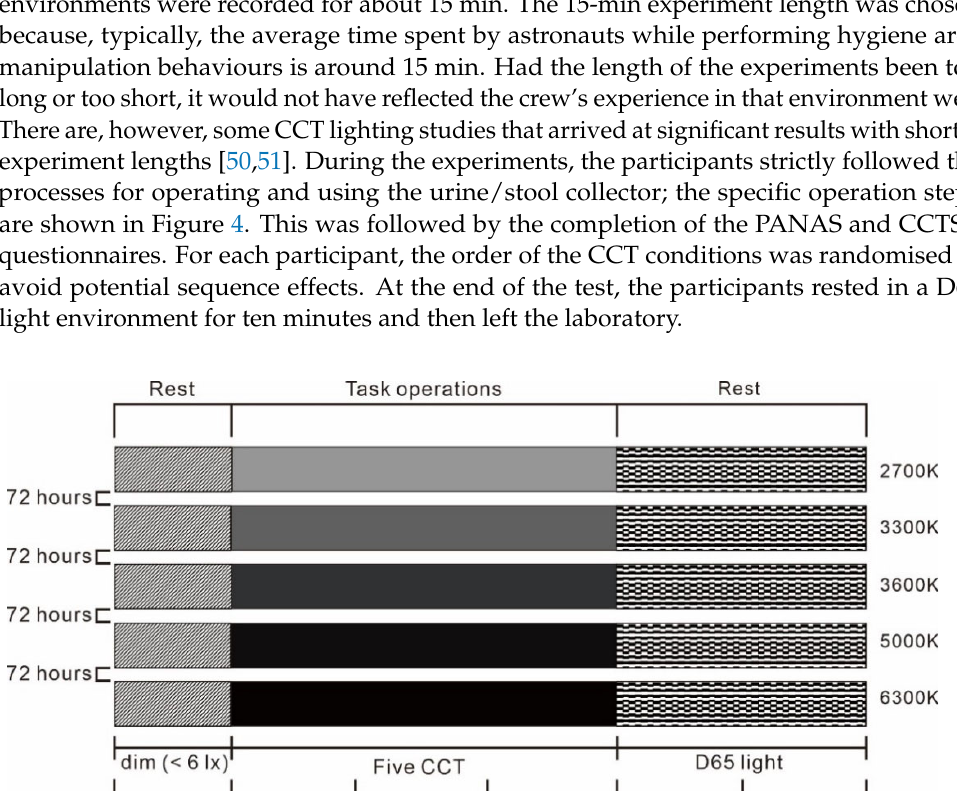
Figure 2. Spectral distribution of the light in the test room at nominal CCTs of 2700 K, 3000 K, 3600 K, 5000 K and 6300 K.